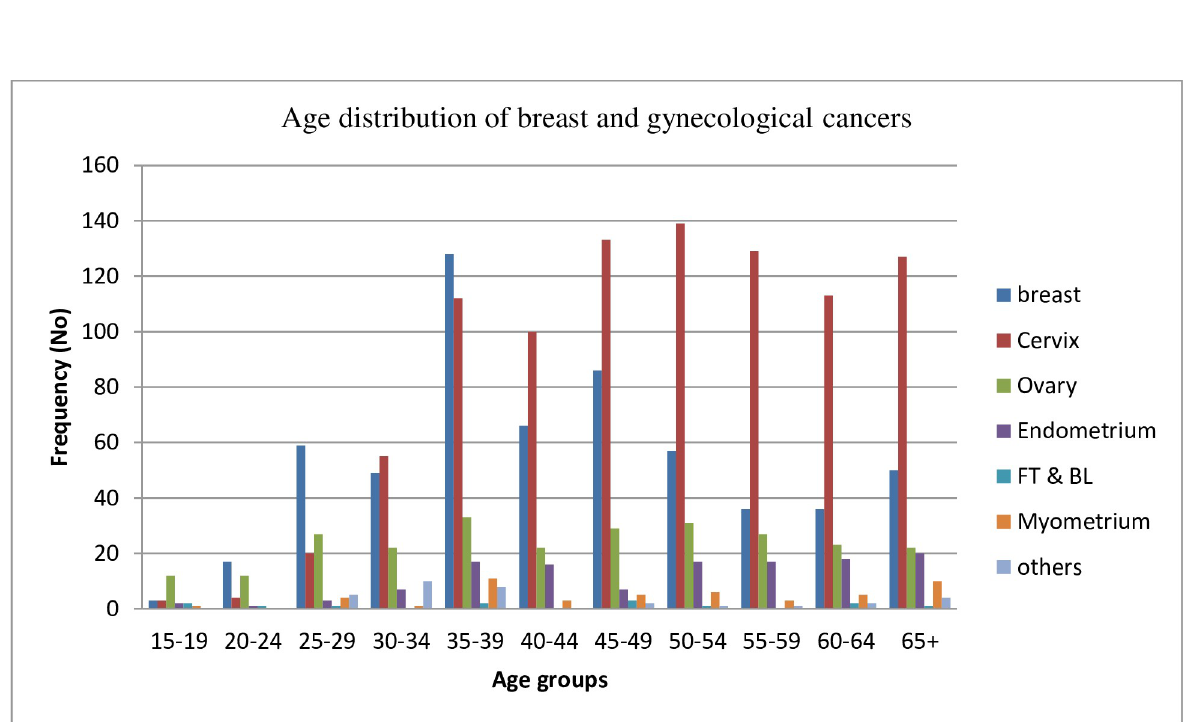
Fig 2. Age distribution of breast and gynecological cancers presenting at SPHMMC, 2014–2018.